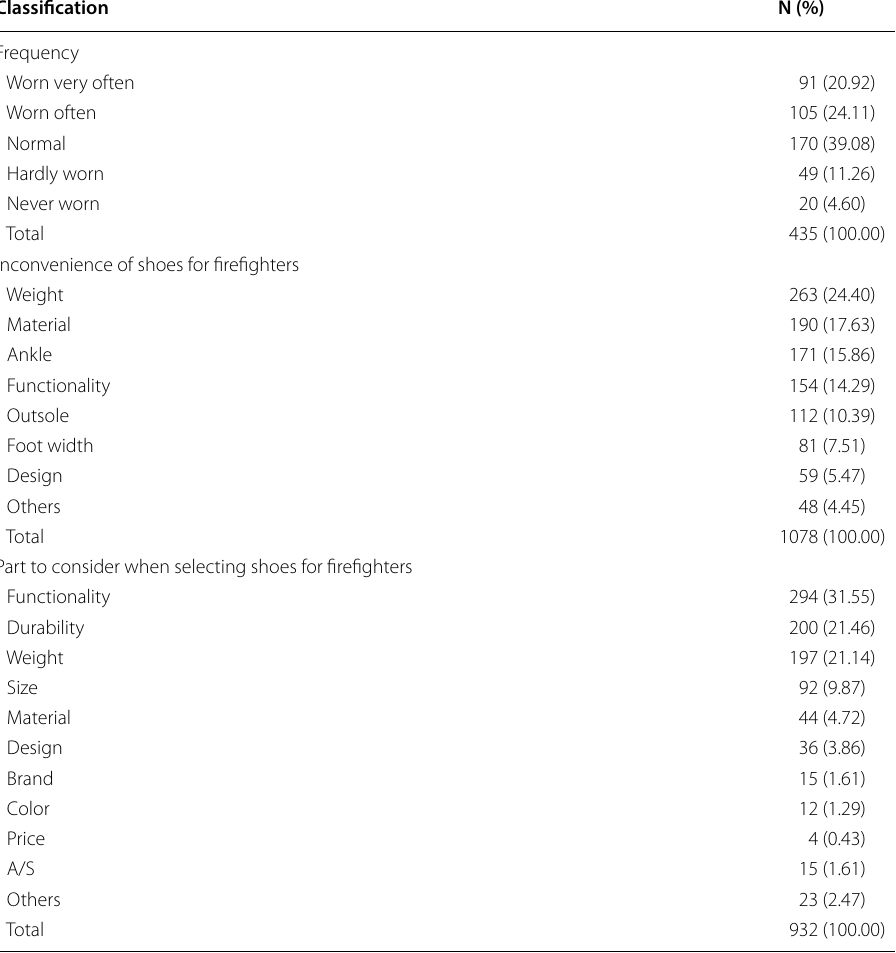
Table 1 Satisfaction of protective footwear for firefighters in Korea Classification N